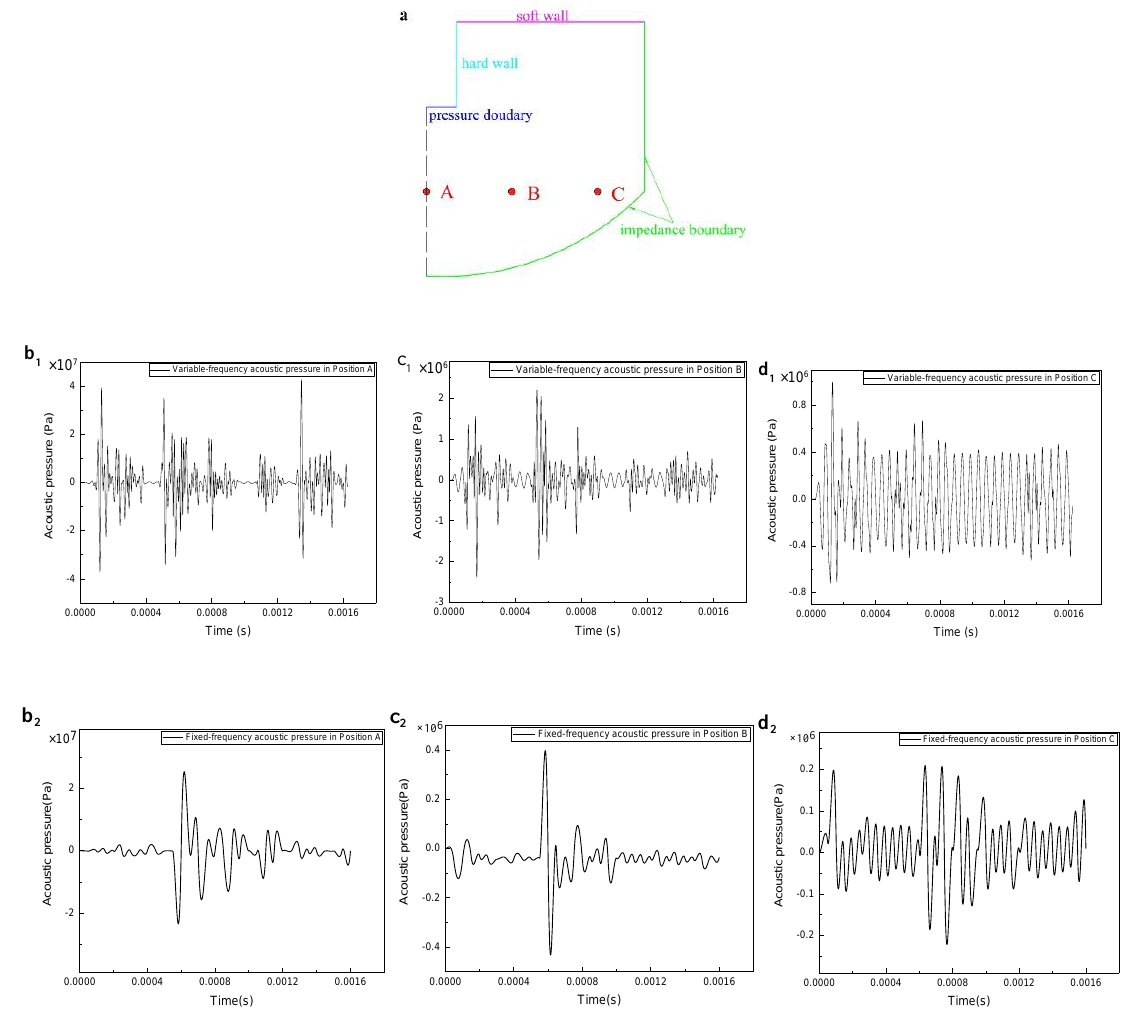
Figure 8. Variable-frequency acoustic pressure at position A ( b 1 ); position B ( c 1 ); and position C ( d 1 ) and fixed-frequency acoustic pressure at position A ( b 2 ); position B ( c 2 ); and position C ( d 2 ). ( a ) Boundary conditions.